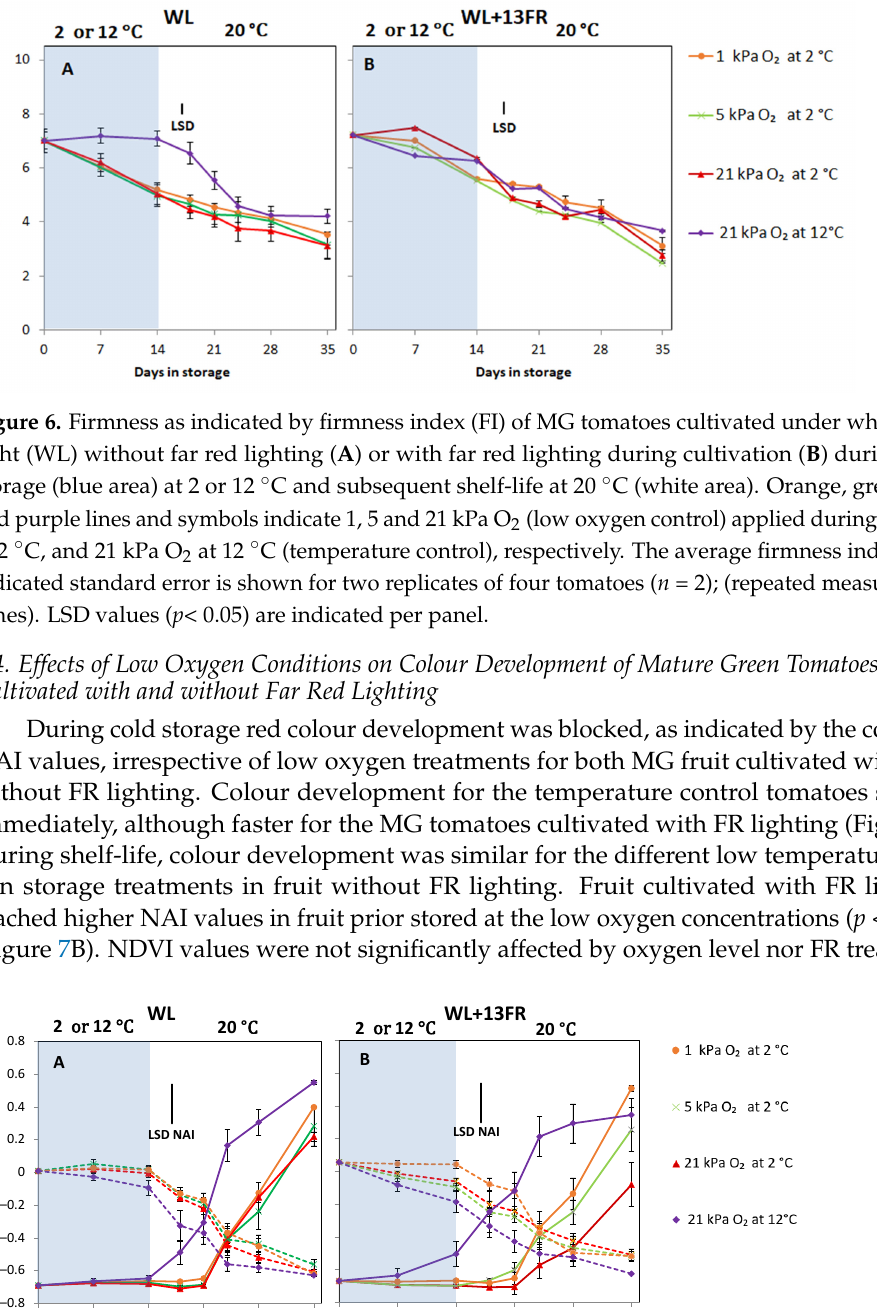
Figure 3. Moran scatterplots of carbon productivity in the central and western regions (2000 and 2018) .